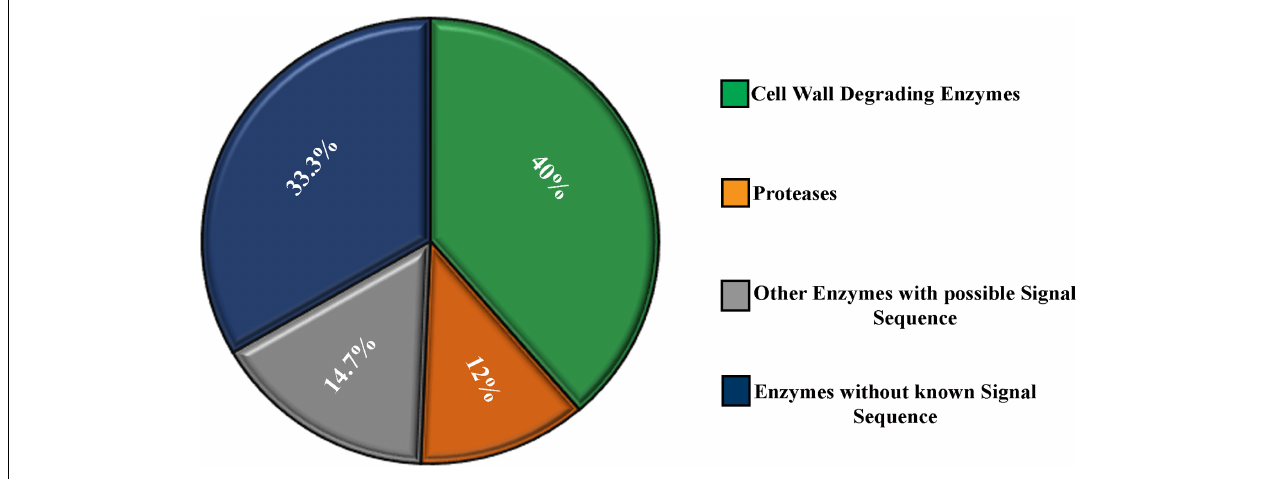
FIGURE 3 | Characterization of the secretome enzymes of M. phaseolina identified by LC-ESI-MS/MS analysis. Most of the proteins found in the secretome were enzymes. Almost 40% of the enzymes were cell wall–degrading enzymes. Twelve percent of the enzymes were proteases. A significant portion (14.7%) of the enzymes contains secretory signal sequence, and the rest 33.3% of the enzymes do not contain secretory signal sequence analyzed by signal P.